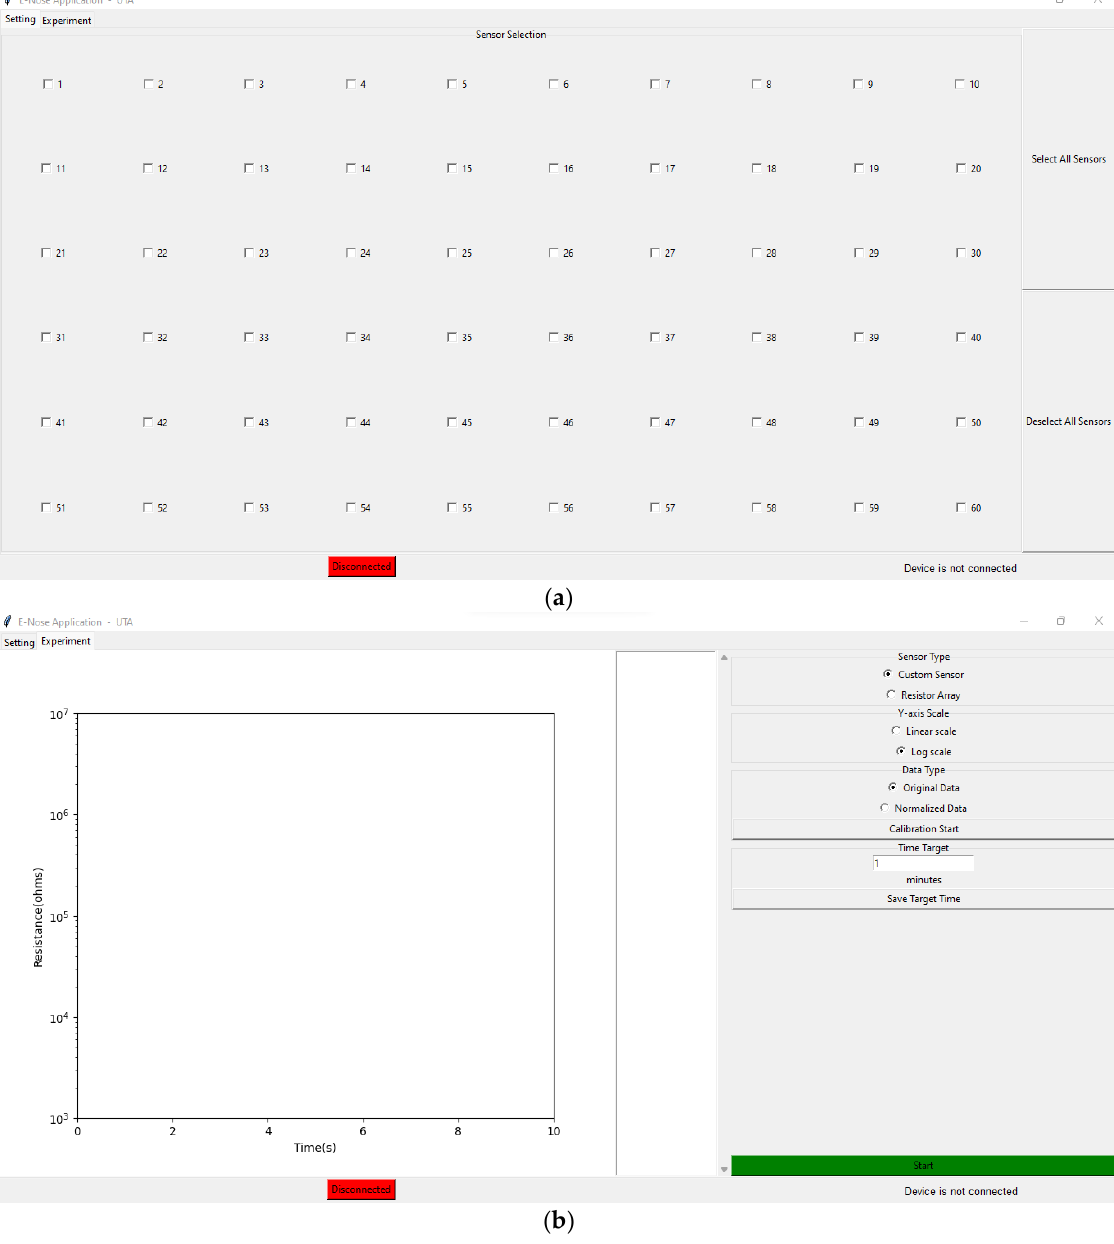
Figure 6. ( a ) Sensor setting window of the graphical user interface (GUI); ( b ) experiment window of the GUI.